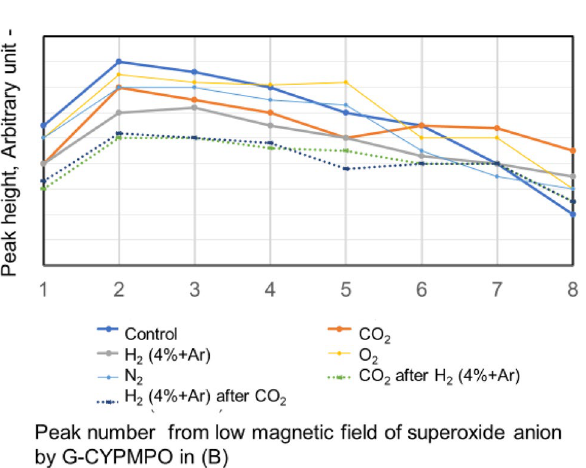
Figure 3. Comparison between different kinds of gas nanobubble peak height of peak number of superoxide anions from low magnetic field shown in (B) of Fig. 1 of superoxide anion radical by